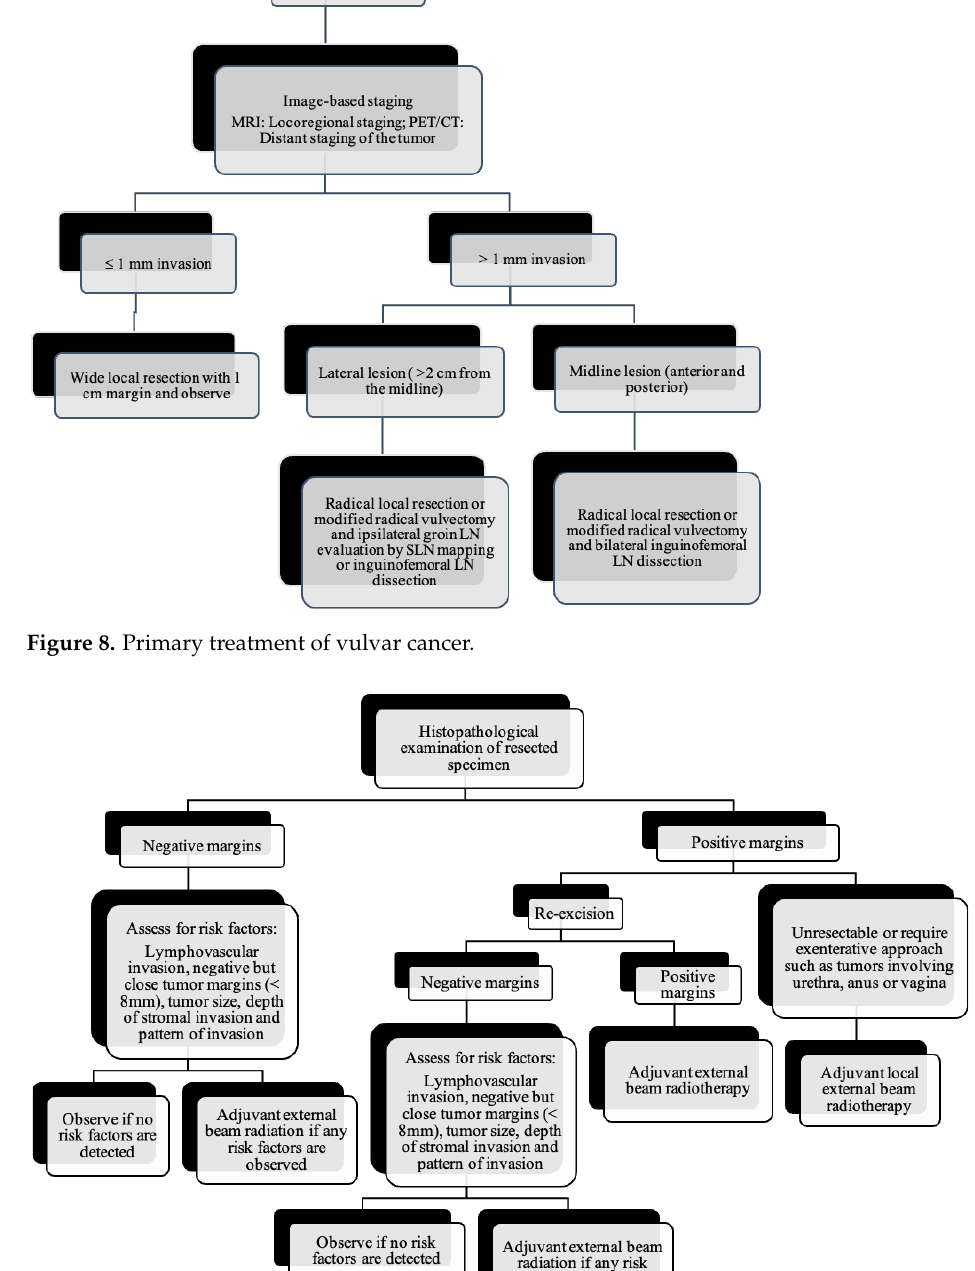
Figure 10. Lymph node evaluation and treatment in patients with vulvar cancer. SLN mapping was introduced in 1977 by Cabanas and in 1994 for the first time in the vulvar cancer [23,43]. Previously, radical surgery with IFLD was the standard treatment for early-stage vulvar cancer. Although radical surgery improved the 5-year survival